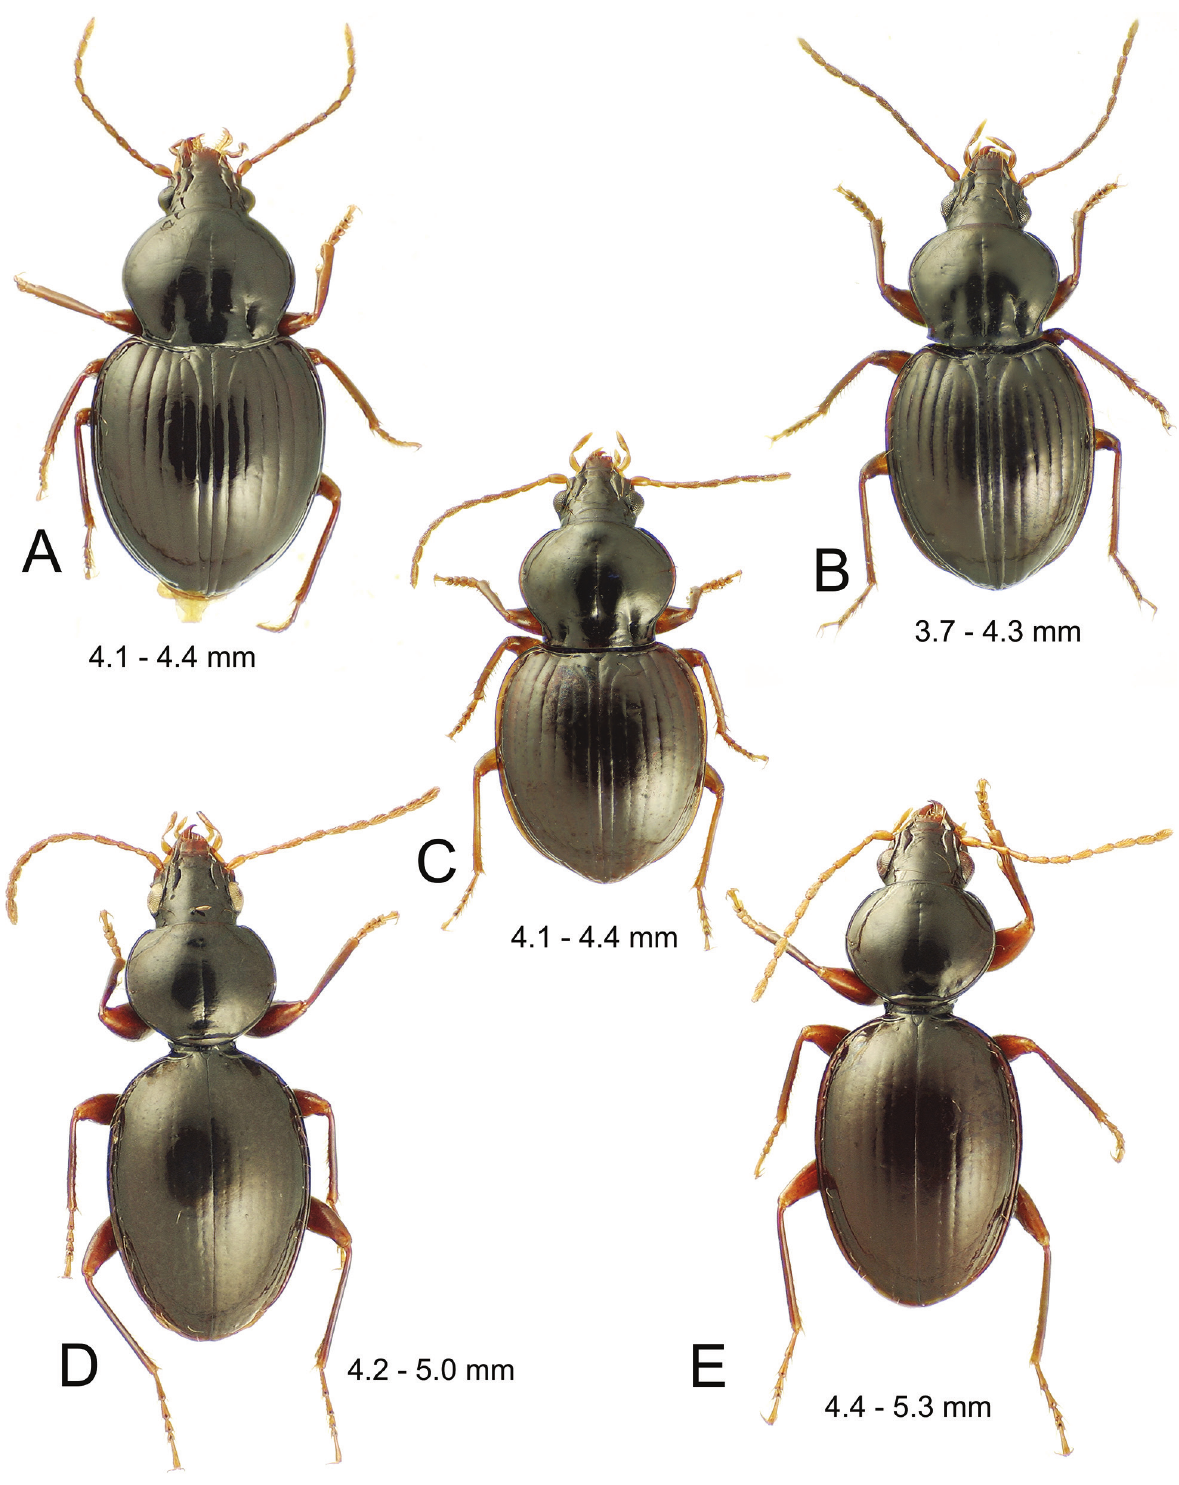
Figure 9. New Caledonian Mecyclothorax ( Phacothorax ) spp., dorsal view: A , M. laterobustus ; B , M. laterosinuatus ; C , M. later- orectus ; D , M. fleutiauxi ; E , M. jeanneli